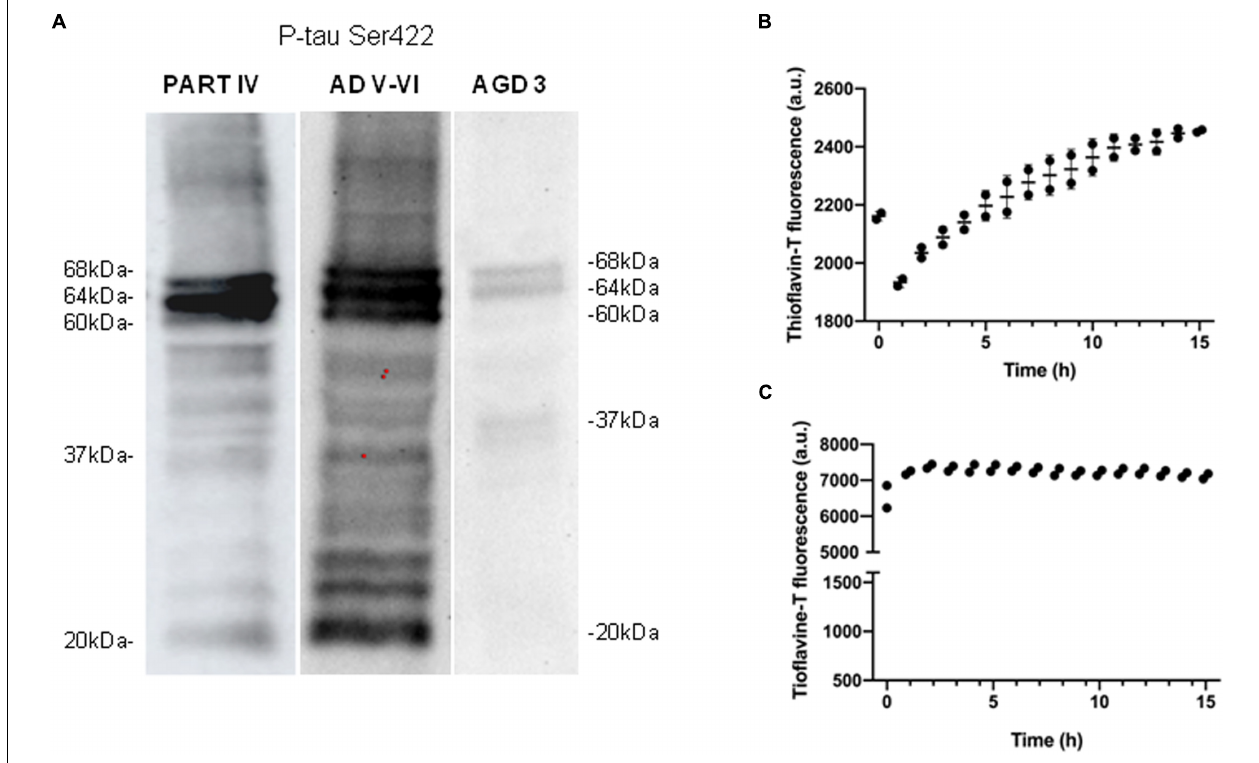
FIGURE 2 | Characteristics of sarkosyl-insoluble fractions. Western blotting processed with anti-phospho-tau Ser422 (P-tau Ser422) in PART stage IV and AD stages V–VI reveals three bands of 68, 64, and 60 kDa, and upper oligomeric smears, in addition to several bands of about 50 kDa, between 30 and 40 kDa, and lower bands of truncated tau at the C-terminal, one of them of about 20 kDa. In contrast, “pure” AGD reveals two bands of 68 and 64 kDa, and a weak band of about 37 kDa (A) . Thioflavin T incubation of sarkosyl-insoluble fractions shows slightly increased fluorescence with time indicating moderate fibril formation in AGD up to 2,500 au (B) , and rapid and higher fluorescence in PART reaching about 7,500 au up to 15 h of incubation (C)